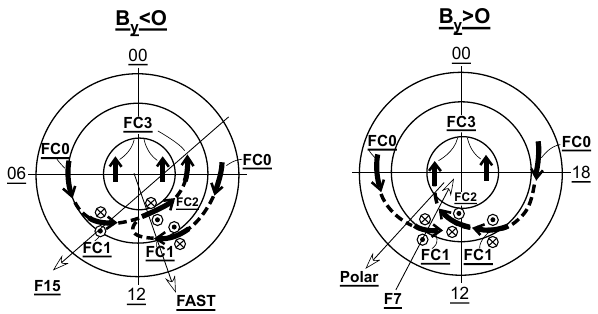
Fig. 3. Schematic illustration of ionospheric plasma flow channels FC 0, FC 1, FC 2 and FC 3 in MLT/MLAT coordinates as extracted from the statistical ground magnetic perturbations of Weimer et al. (2010). Flow patterns for southwest ( B y < 0) and southeast ( B y > 0) IMF orientations are shown in the left and right-side pan- els, respectively. The polarities of paired FAC sheets associated with the FC 1 and FC 2 ionospheric flows are indicated. Also shown are specific tracks of satellites (DMSP F15, FAST, Polar and DMSP F7) used to document the FAC and plasma